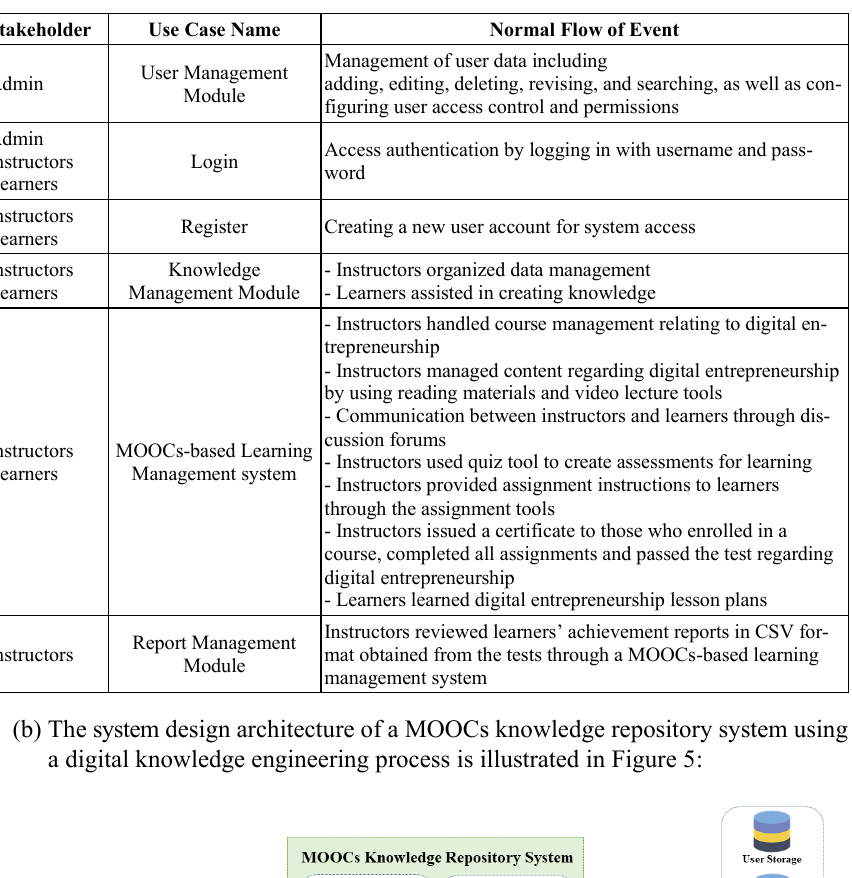
Table 1. Use Case Description